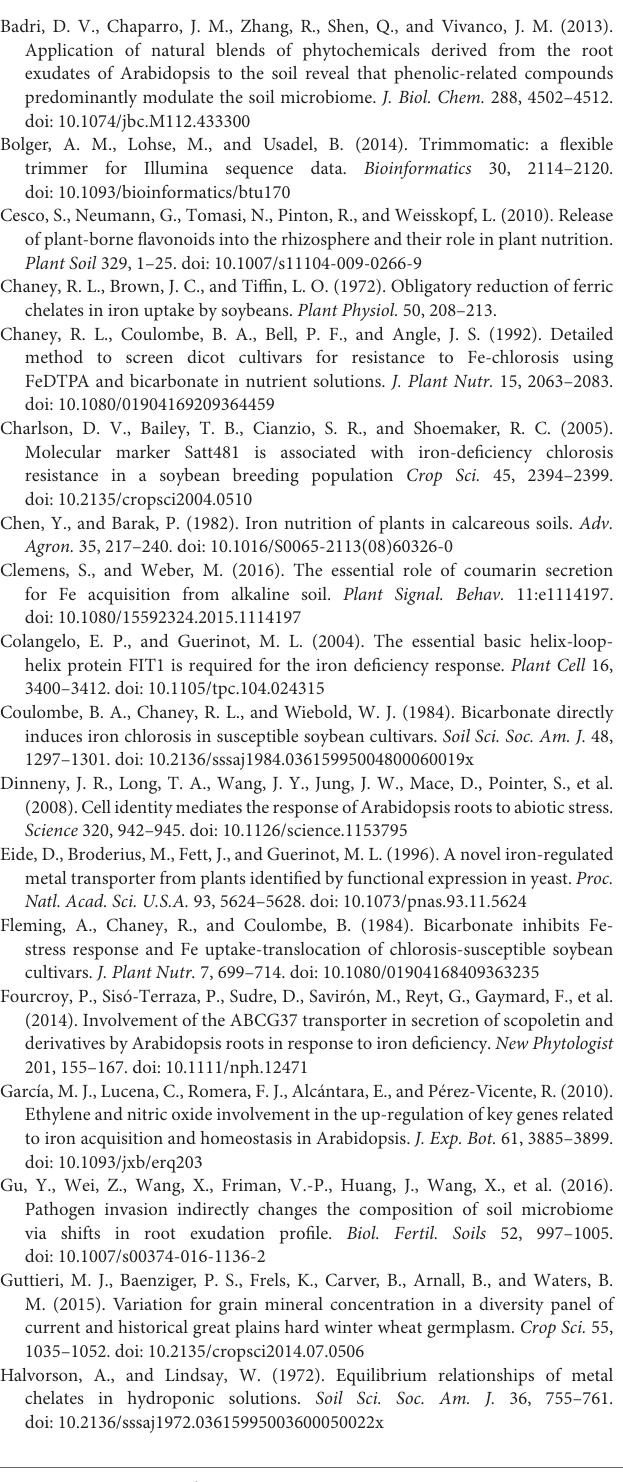
Supplementary Table 1 | All genes that were differentially expressed by Fe or Bic treatments. Supplementary Table 2 | Selected differentially expressed genes. Supplementary Table 3 | Soybean homologs of Arabidopsis genes that are upregulated by microorganisms.